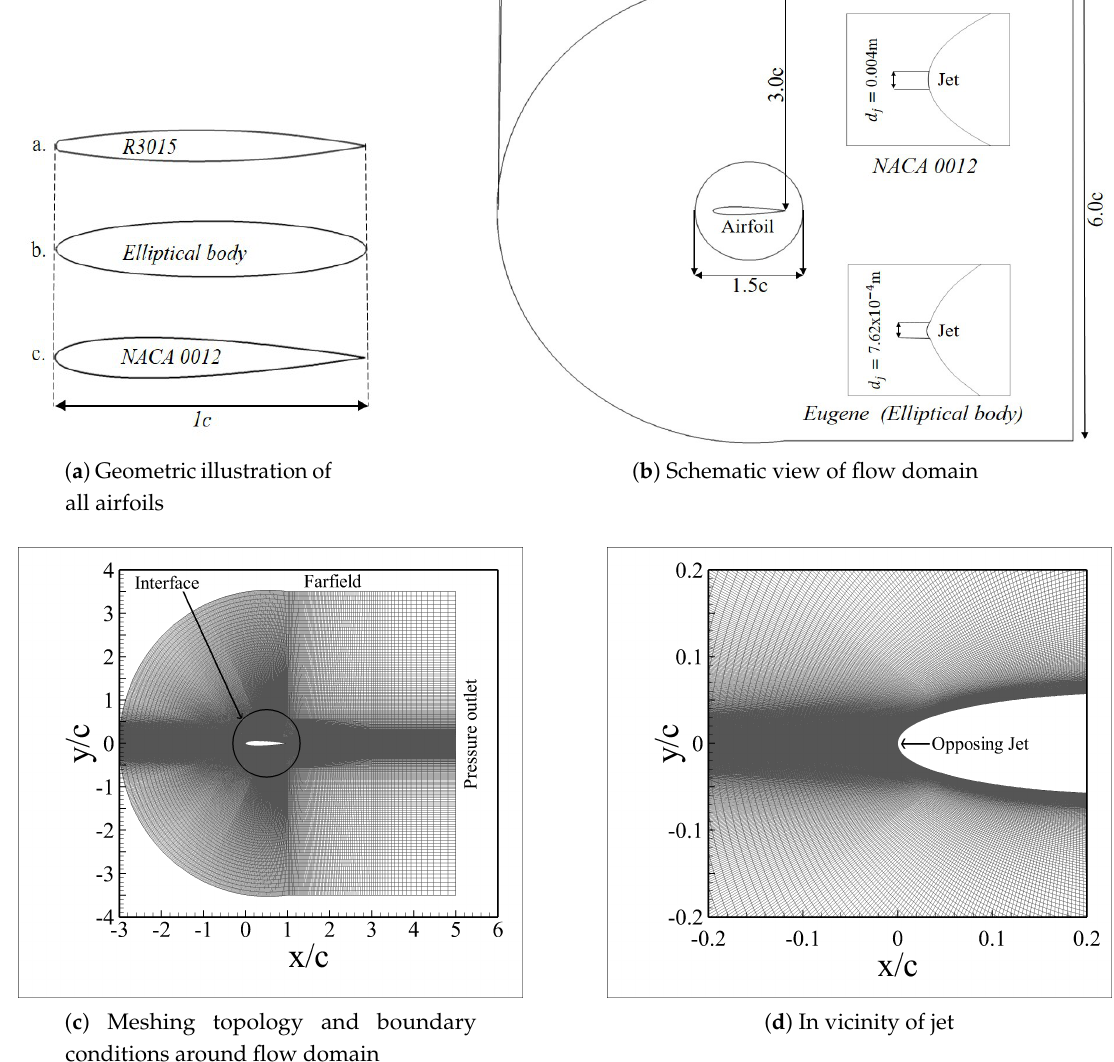
Figure 2. Numerical grid distribution with boundary